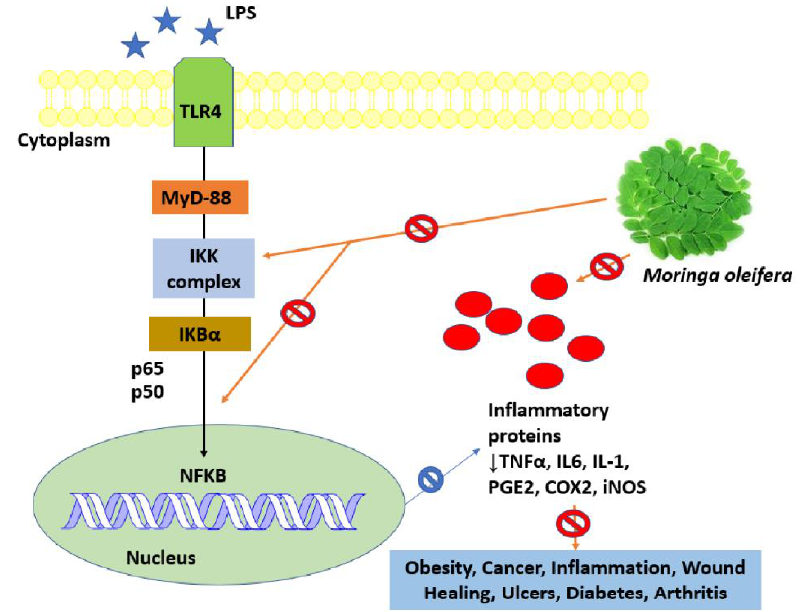
Figure 4. M. oleifera , as an oxidative and inflammatory marker, inhibits IKB α phosphorylation, thereby preventing NFKB (nuclear factor kappa B) inhibition. It prevents the nuclear translocation and dimerization of IkB α and NFKB, thereby inhibiting the formation of inflammatory proteins such as TNF α (tumor necrosis factor), COX-2(cyclooxygenase-2), IL6(interleukin -6), and iNos(inducible nitric oxide synthase) and thereby reducing the inflammation and curing other disorders like obesity, arthritis, cancer, diabetes, and ulcer.